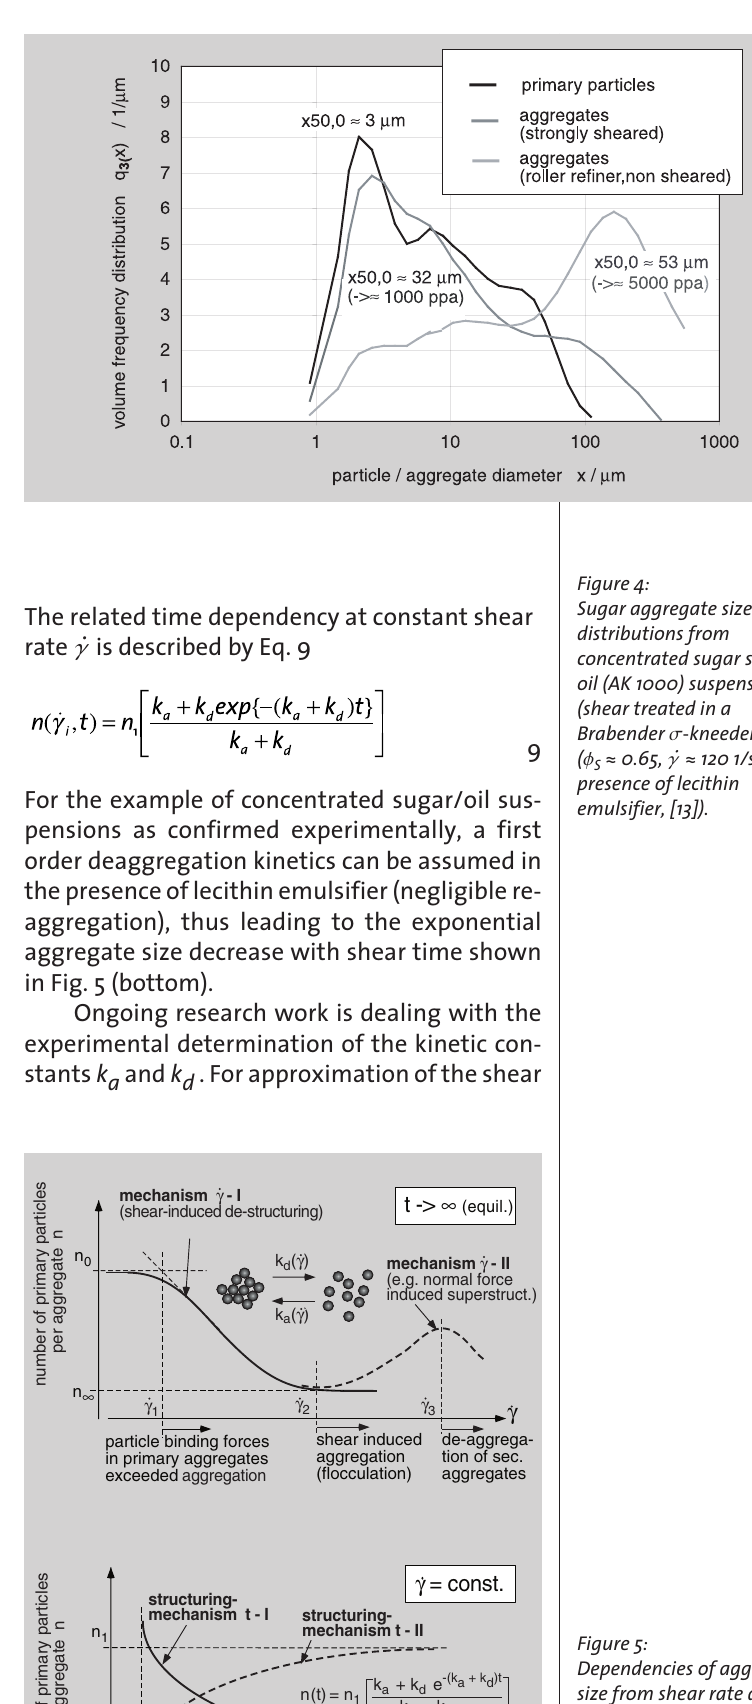
Figure 5: Dependencies of aggregate size from shear rate and shear time approximated from measurements and qualitatively described with a kinetic model for aggregation/deaggre-